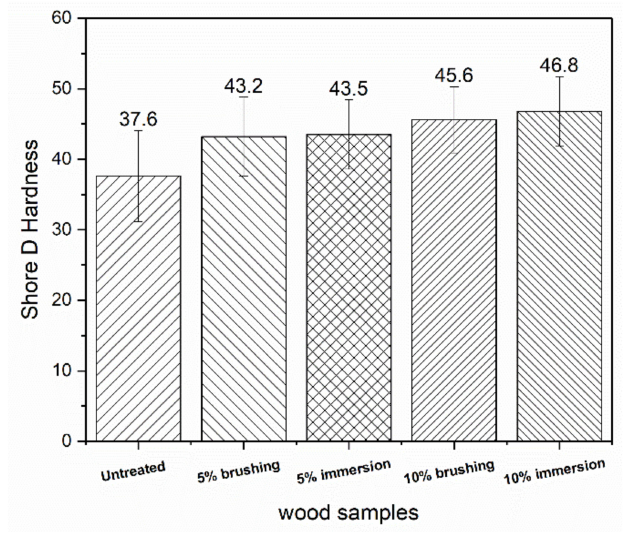
Figure 11. Average values of the Shore D hardness for the samples under